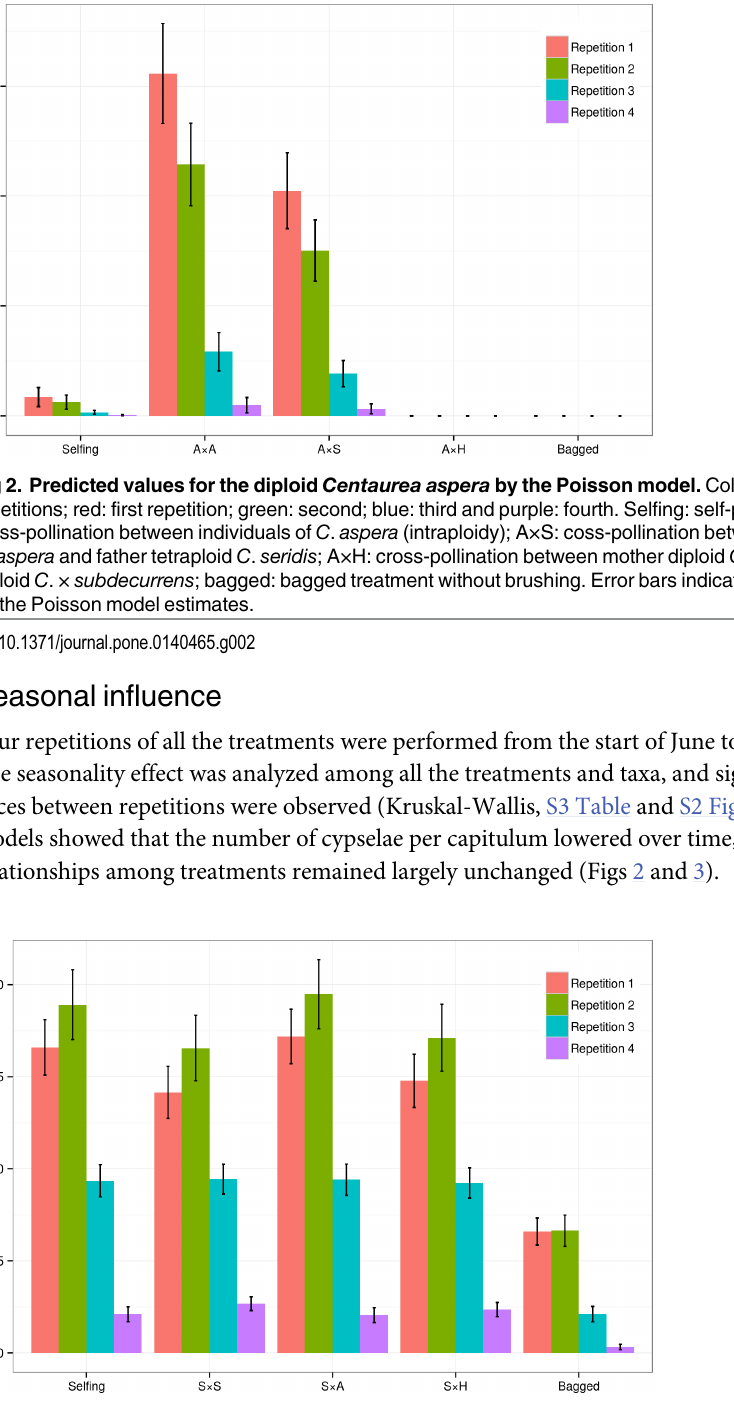
Fig 3. Predicted values for the tetraploid Centaurea seridis by the Zero inflated Poisson model. Colors represent the repetitions; red: first repetition; green: second; blue: third and purple: fourth. Selfing: self- pollination; S×S: cross-pollination between individuals of C . seridis (intraploidy); S×A: coss-pollination between mother tetraploid C . seridis and father diploid C . aspera ; S×H: coss-pollination between mother tetraploid C . seridis and father triploid C . × subdecurrens ; bagged: bagged treatment without brushing. Error bars indicate the standard error for the Poisson model estimates.